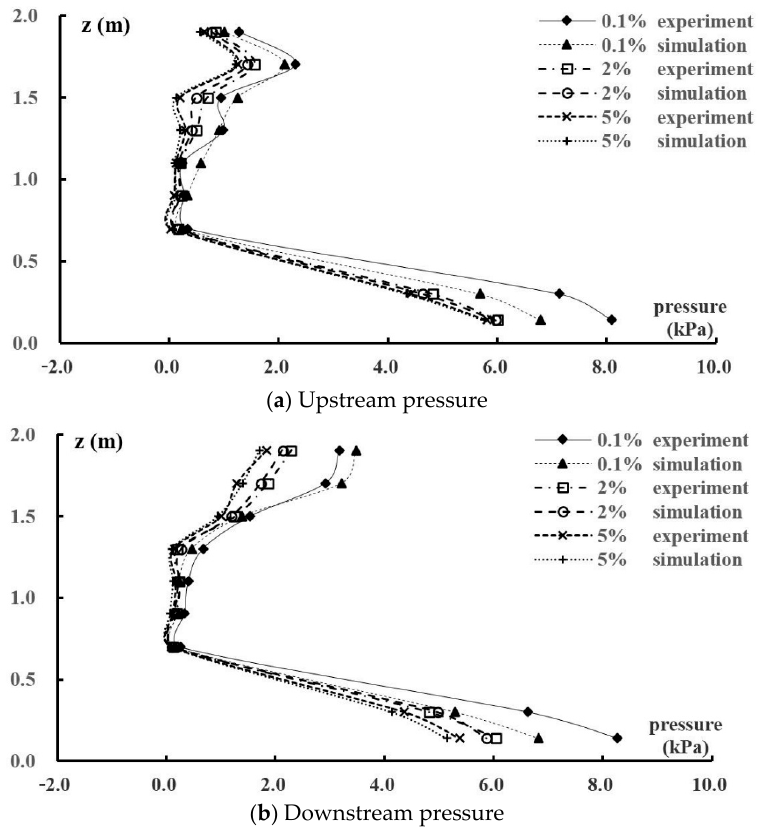
Figure 12. Pressure trends in the vertical shaft.